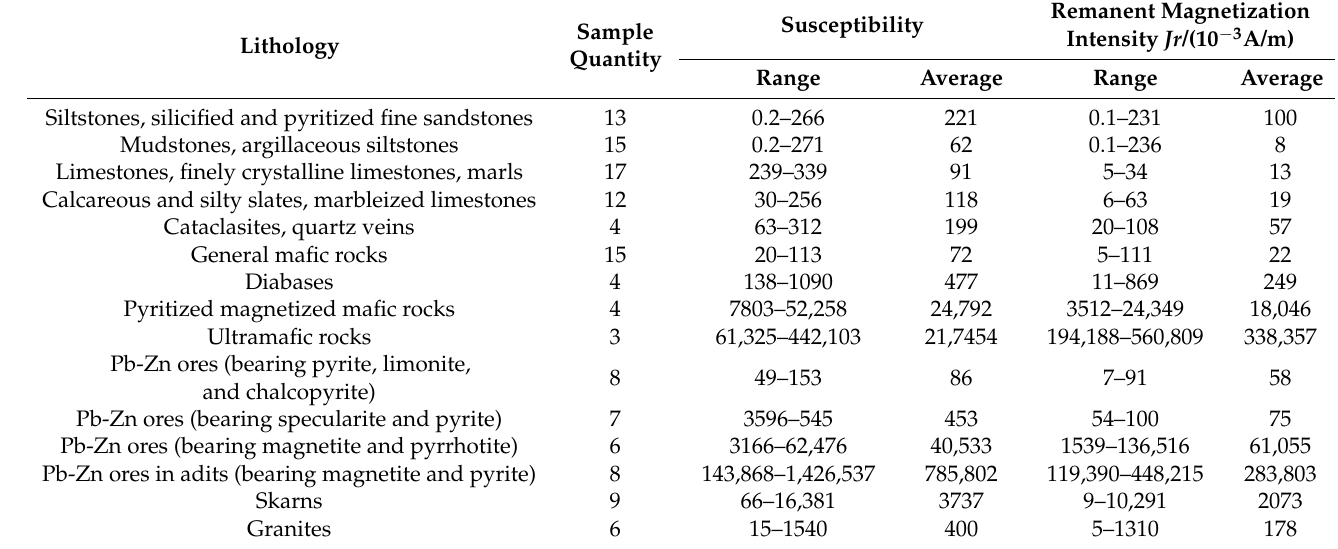
Table 2. Statistics of magnetic parameters of rock samples collected from the Hetaoping ore